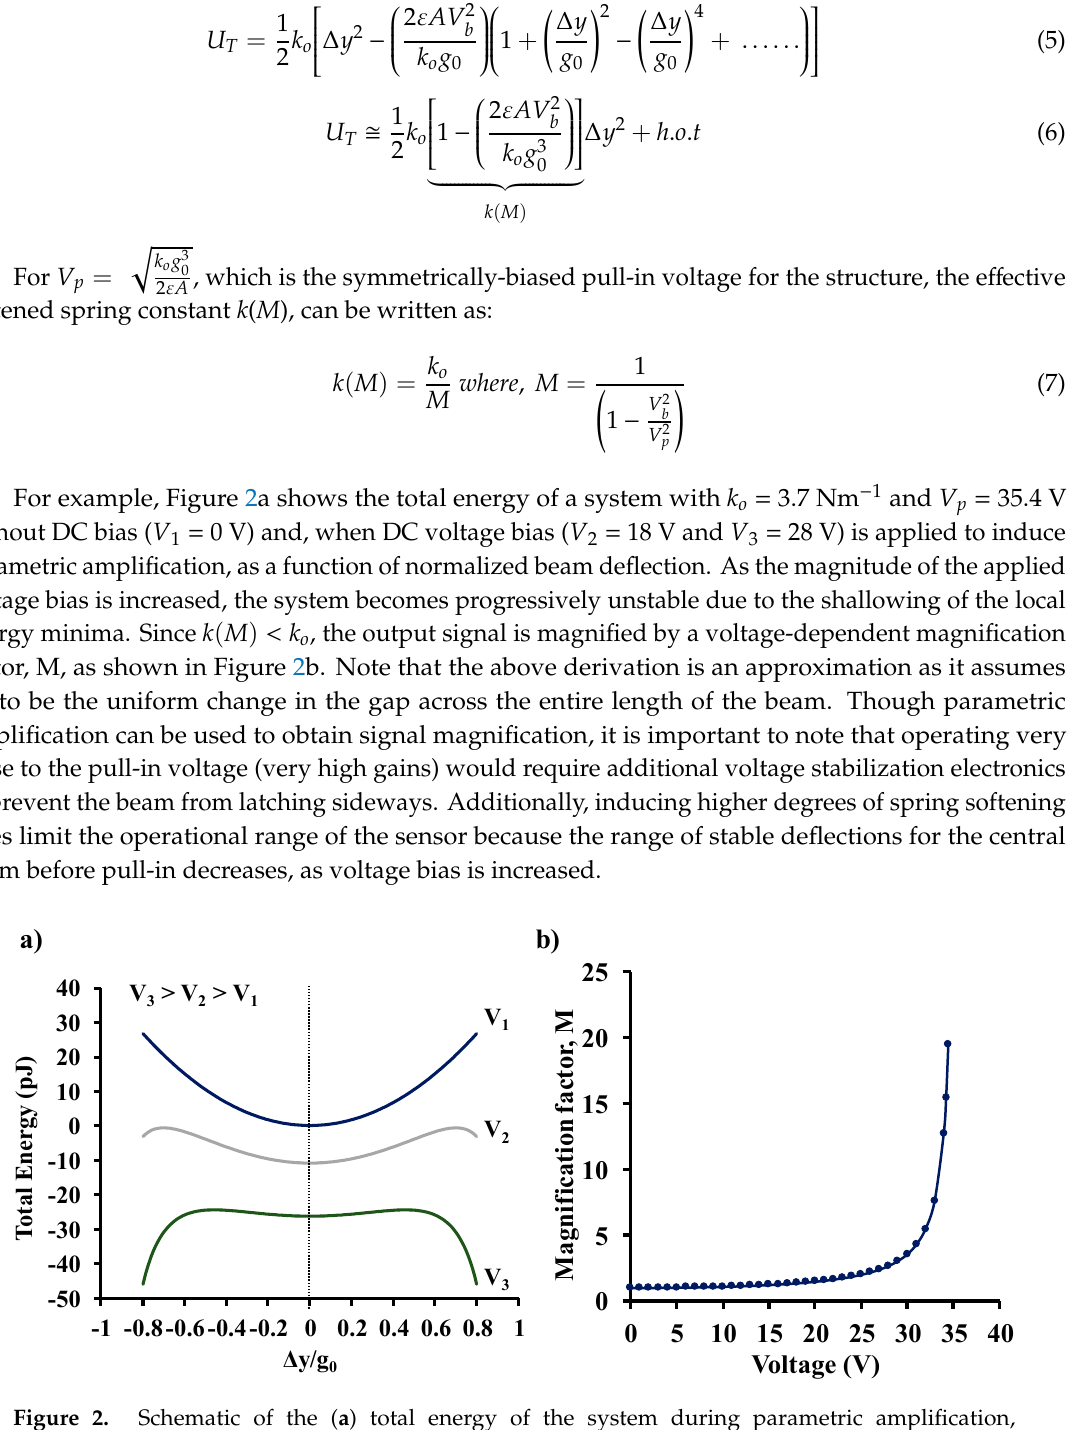
Figure 2. Schematic of the ( a ) total energy of the system during parametric amplification, and ( b ) magnification factor M as a function of the applied voltage.